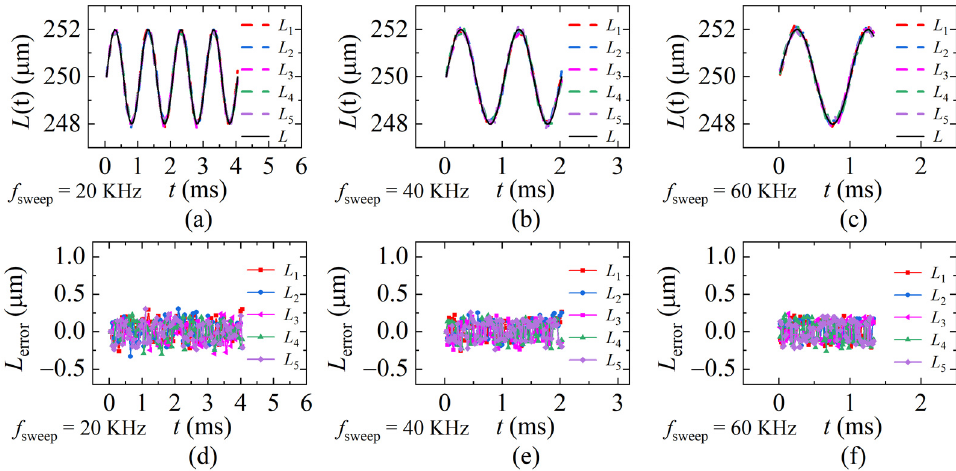
Figure 17. The distances and the errors of the repeatability experiments. L is the ideal distance, L 1 ~ L 5 are the results of the five identical experiments ( a , d ) f sweep = 20 KHz; ( b , e ) f sweep = 40 KHz; ( c , f ) f sweep = 60 KHz ( ω PZT = 1 KHz, v max = 0.01 m/s).